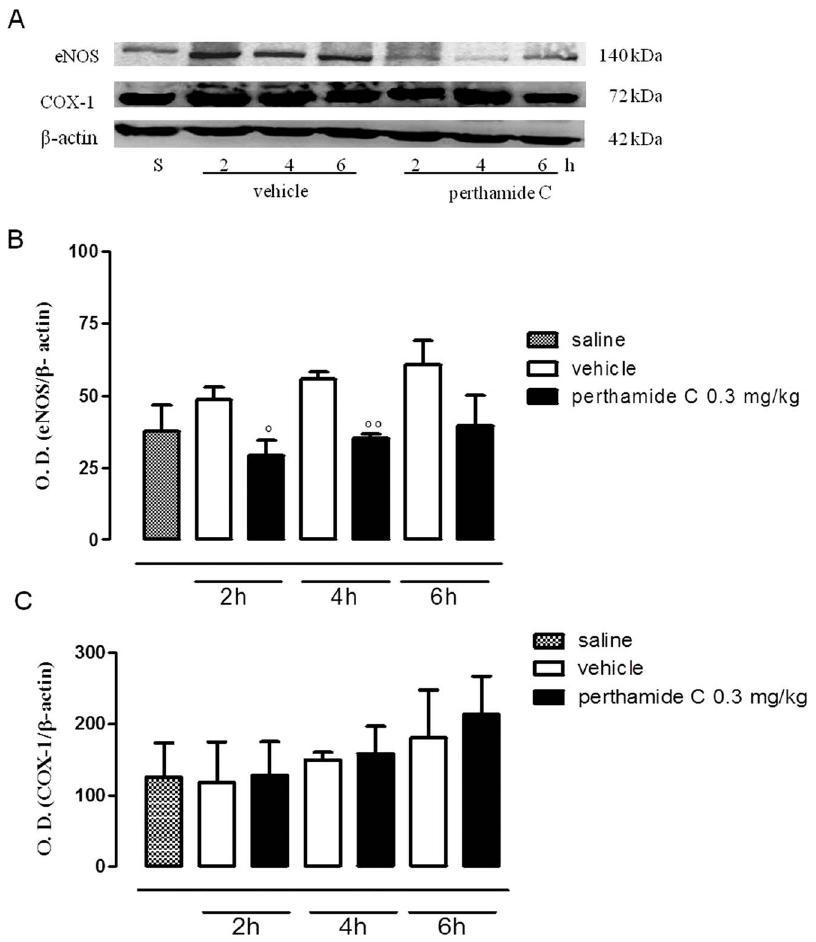
Figure 2. Western blot analysis of eNOS and COX-1 in the early phase of the paw edema. Expression of eNOS and COX-1 (A) were evaluated in total tissue extracts from paw homogenates obtained from mice treated with perthamide C, vehicle or saline at 2, 4 and 6 h following l - carragenan injection (n=4 paws for each treatment and time point). In panel B and C are shown the relative densitometric analysis u P , 0.05, uu P , 0.01 vs vehicle. Image is representative of three separate experiments.